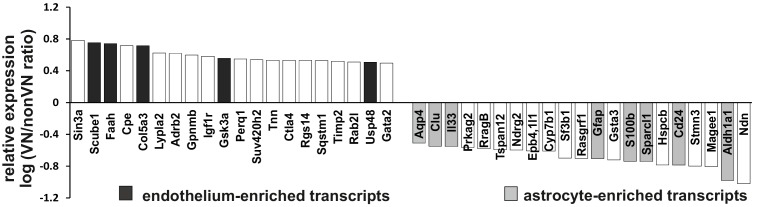
Microarray analysis restricted to defined and putative endothelial and astrocyte enriched transcripts shows the different profiles of both niches in 10 dpl group.For each individual gene average a ratio between average expression in vascular and non-vascular niche were computed. Expression ratios were plotted on a log2 scale. Gene signatures for astroglial-lineage cells (Zhang et al., 2014; Cahoy et al., 2008), oligodendroglial-lineage cells (Zhang et al., 2014; Cahoy et al., 2008), SCs-lineage cells (Schmid et al., 2014), and endothelial cells (Daneman et al., 2010; Zhang et al., 2014) were extracted from the literature and crossed with our microarray data. On the left are genes overexpressed in vascular niche, and on the right genes overexpressed in non-vascular niche with marked genes of known cellular sources based on Gene Atlas and previously published databases. Note a higher representation of endothelial enriched genes in perivascular niche and astrocyte enriched genes in non-vascular one.